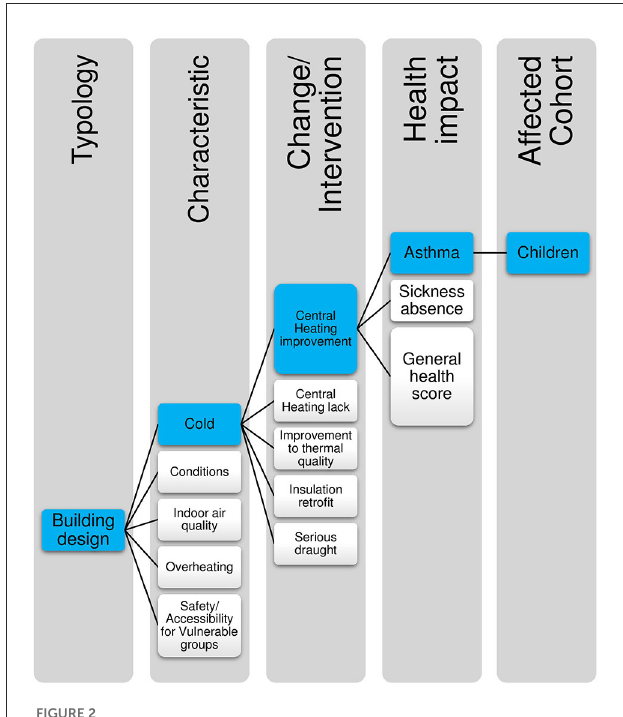
FIGURE2 Illustration of how impact pathways are defined: highlighted in blue is the specific pathway for central heating improvements and asthma in